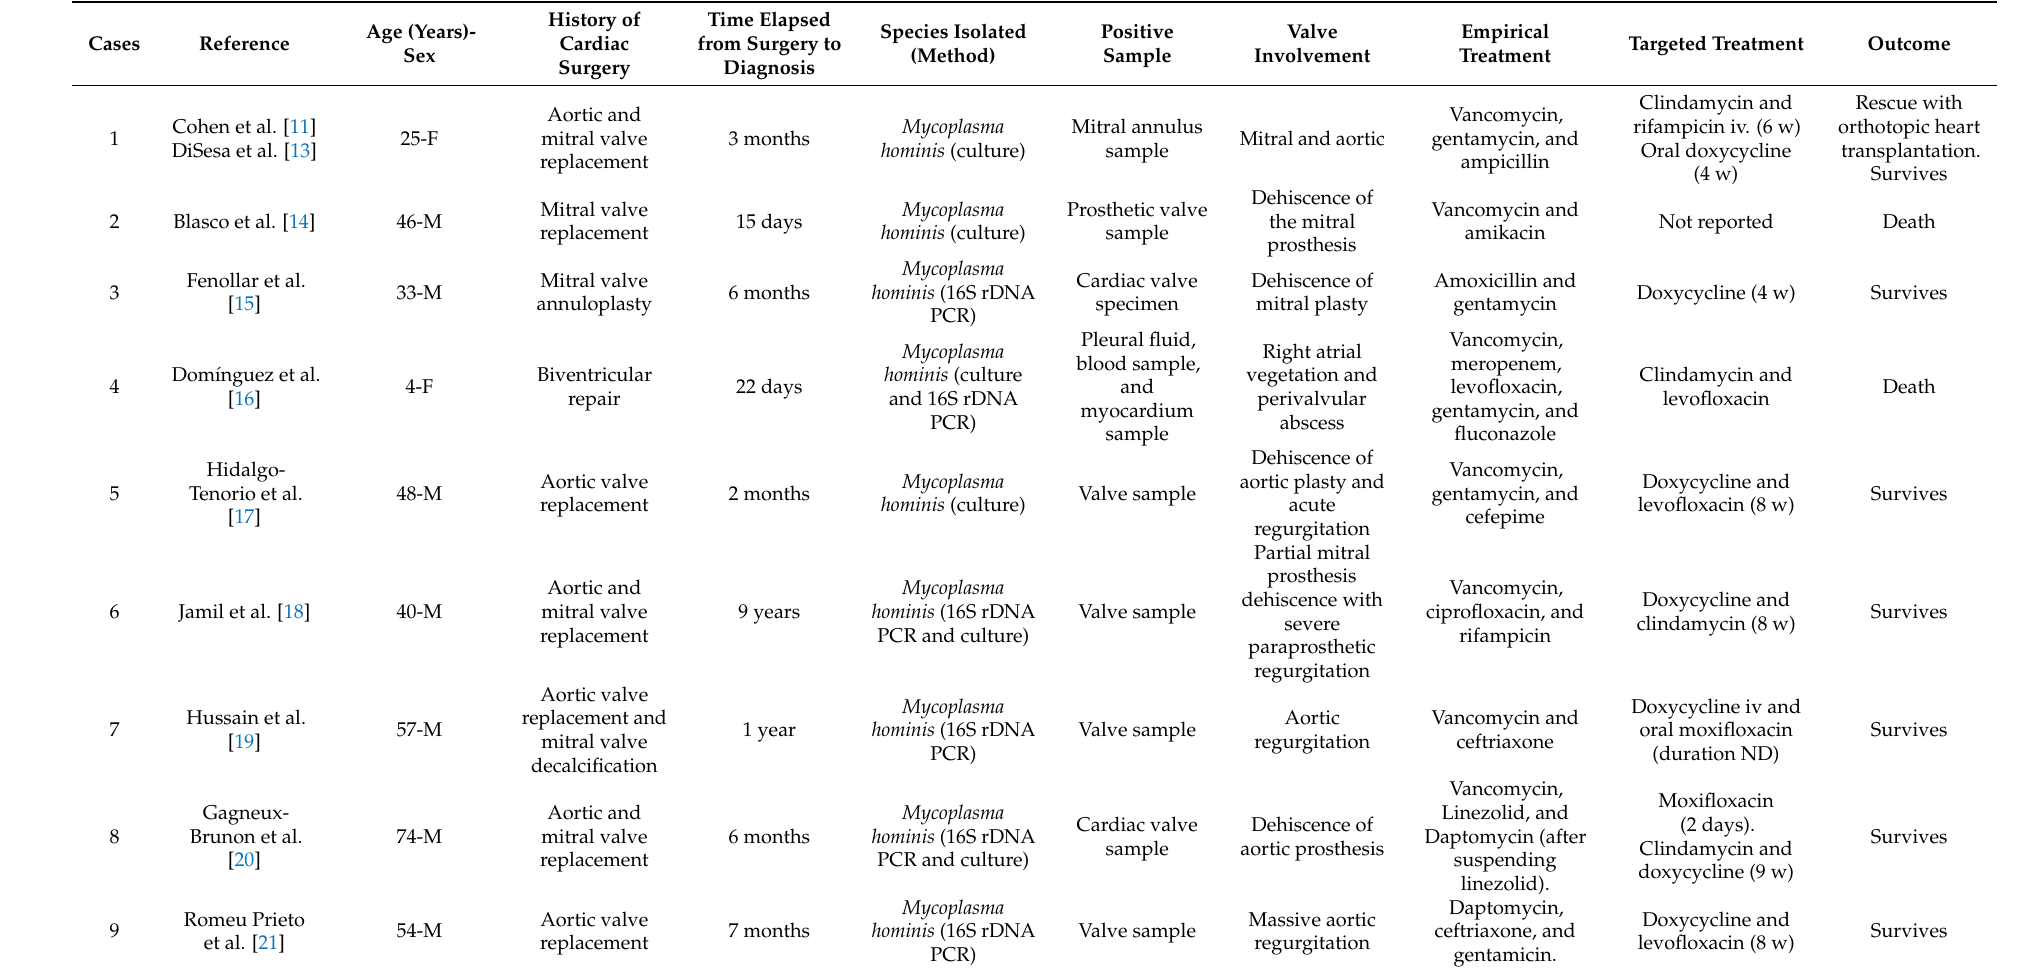
Table 2. Cases of endocarditis and M. hominis documented in the